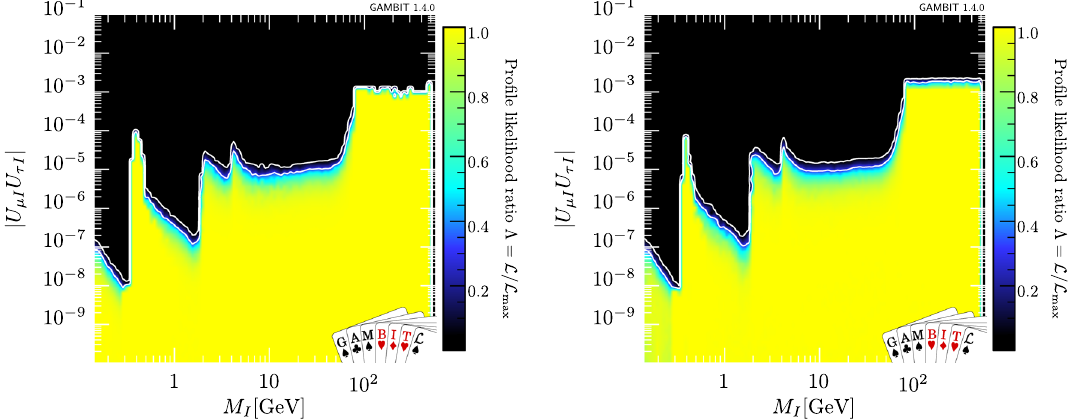
Fig. 7 Profile likelihood in M I vs | U μ I U τ I | plane for normal (left) and inverted hierarchy (right). Tables with the 90% and 95% CLs for both hierarchies can be found in Zenodo